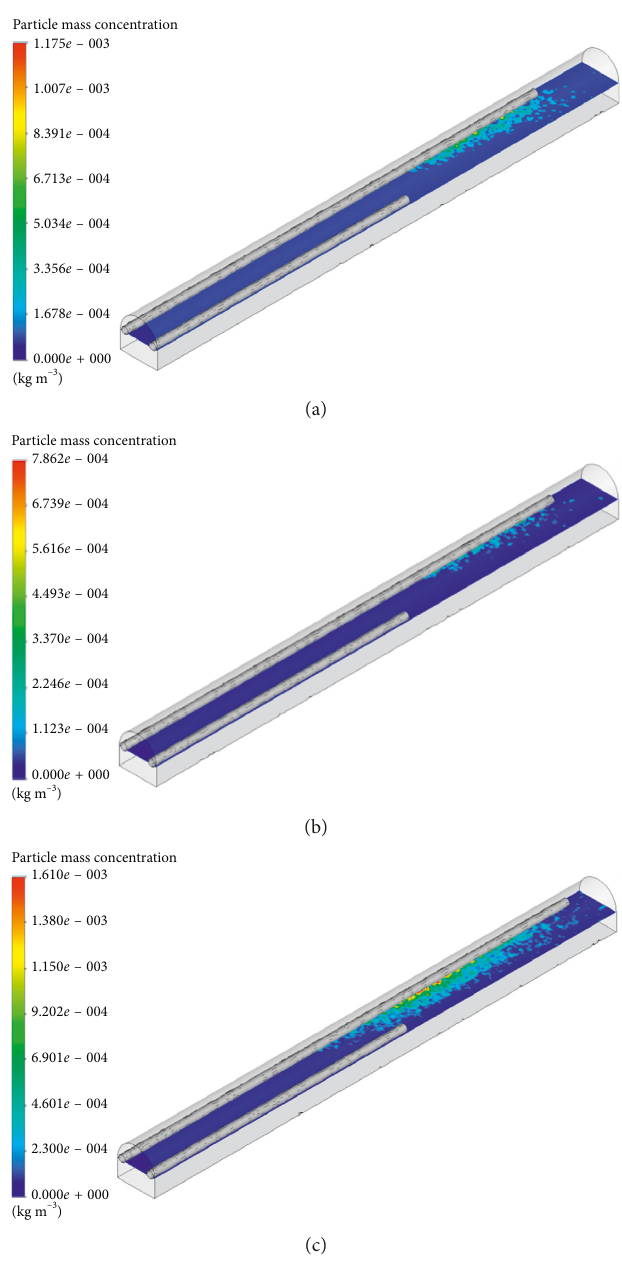
Figure 8: Influence of L on the mass concentration of dust. (a) 1.5 m, (b) 3.0 m, and (c) e - inlet